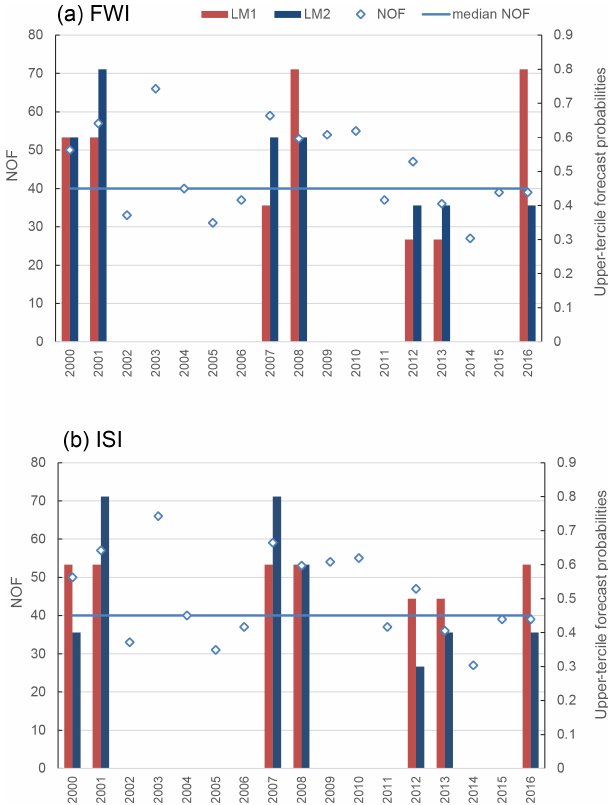
Figure 7. Annual number of fires (NOF) in Attica (blue dia- monds), median of fire events for 2000–2016 (blue line), and upper- tercile forecast probabilities of the (a) FWI and (b) ISI for the best-performing 1-month (red columns; LM1) and 2-month (blue columns; LM2) lead time spin-up